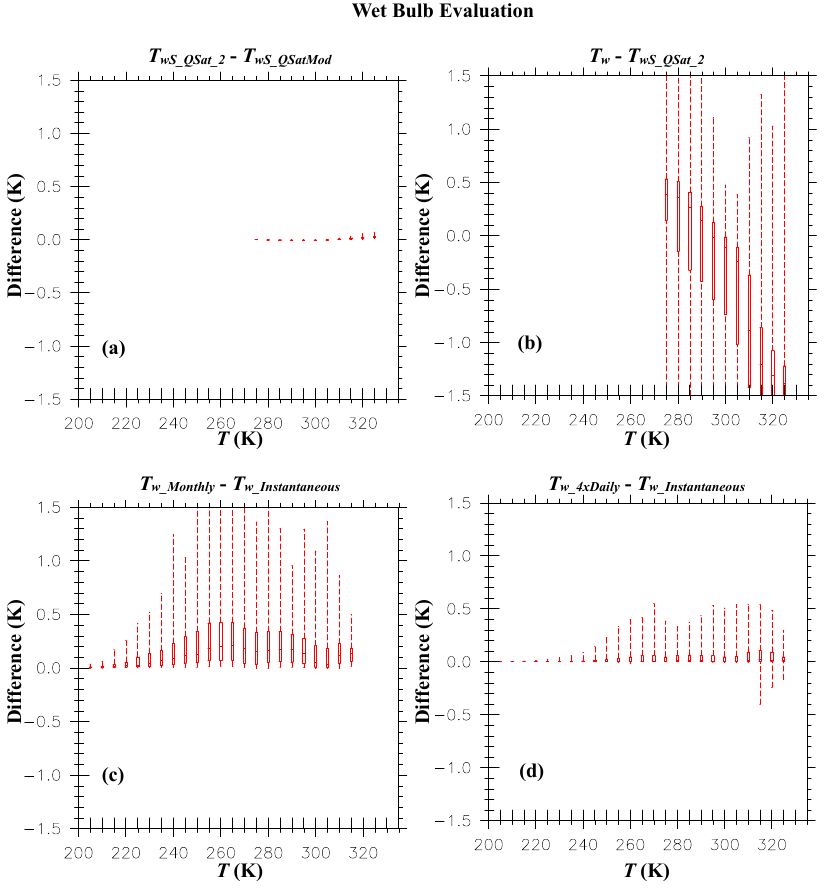
Figure 1. Evaluation of wet bulb temperatures. The boxes represent the 90% confidence interval. The upper and lower tails represent the 100% confidence interval. The horizontal line in each box is the median value. (a) is the difference between T wS using QSat_2 saturated vapor pressure and QSatMod saturated vapor pressure over the valid range for T wS . (b) is the difference between T w (Davies-Jones, 2008) and T wS (Stull, 2011) (both using QSat_2 saturated vapor pressure calculation) over the valid range for T wS . (c) is the difference between using model monthly averaged input fields and model instantaneous fields to calculate monthly T w . (d) is the difference between using model 4 × daily averaged input fields and model instantaneous fields to calculate 4 × daily T w . For (a) , (b) , and (d) the inputs of T , P , and Q are derived from model 4 × daily fields from the years 2001–2010. For (c) the inputs of T , P , and Q are derived from model monthly fields from the years